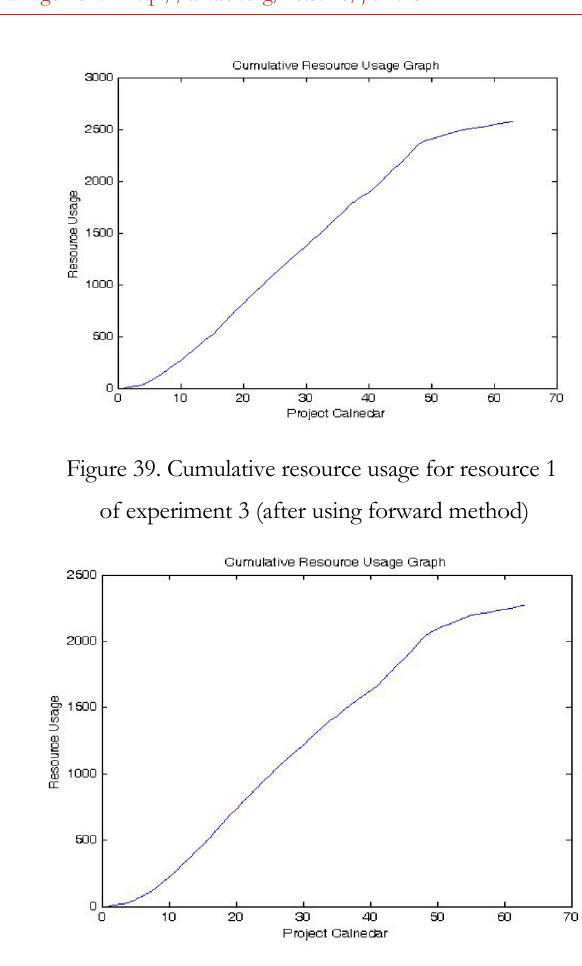
Figure 40. Cumulative resource usage for resource 1 of experiment 3 (relaxed resource constraint)